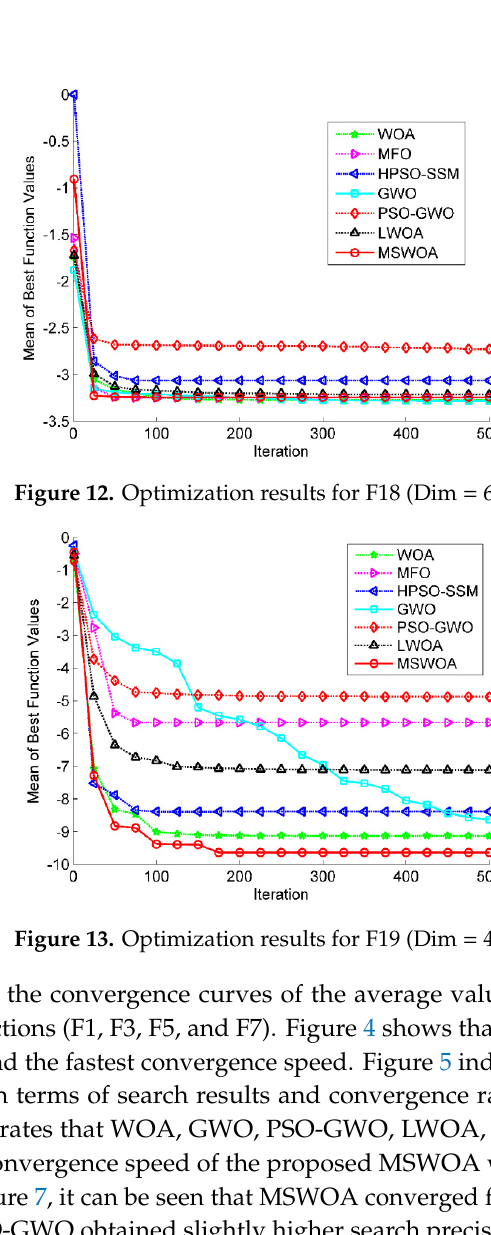
Figure 11. Optimization results for F15 (Dim = 4).